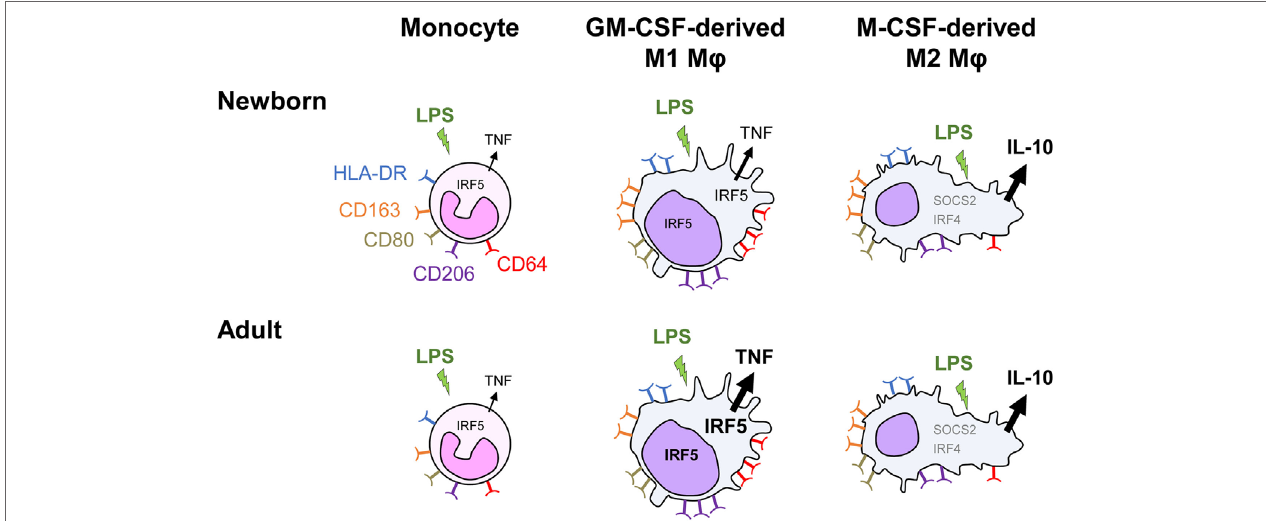
FigUre 7 | Distinct TLR4 response in neonatal monocyte-derived macrophages. Exposure of newborn and adult monocytes to GM-CSF and M-CSF drives their differentiation into macrophages having an M1 (CD64 high and CD206 high round cells) and an M2 (SOCS2 high , IRF4 high and CD163 high elongated cells) phenotype. Macrophages express high levels of membrane-bound HLA-DR, CD80, CD163, and CD206, with newborn M1 macrophages expressing higher levels of the hemoglobin scavenger receptor CD163 than adult M1 macrophages. Following TLR4 stimulation, newborn monocytes secrete TNF to a similar level as adult monocytes. M1 macrophages secrete higher levels of TNF but low levels of IL-10, whereas M2 macrophages secrete low levels of TNF but high levels of IL-10. TNF secretion is threefold to sixfold lower in newborn than in adult M1 macrophages, while the production of other cytokines (IL-1 β , IL-6, IL-8, and IL-23) is at similar levels. IRF5, a transcription factor implicated in M1 polarization, increases in the cytoplasm and in the nucleus during monocyte to M1 macrophage differentiation. Both cytoplasmic and nuclear levels of IRF5 are lower in newborn than adult M1 macrophages. IRF5 overexpression in newborn M1 macrophages restores LPS-induced TNF production in newborn M1